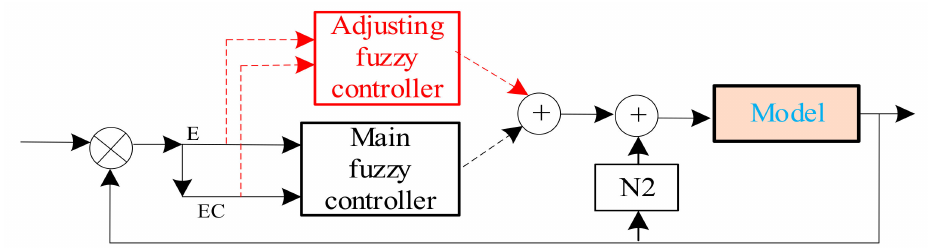
Figure 3. Structure of self-tuning double yaw rate feedback